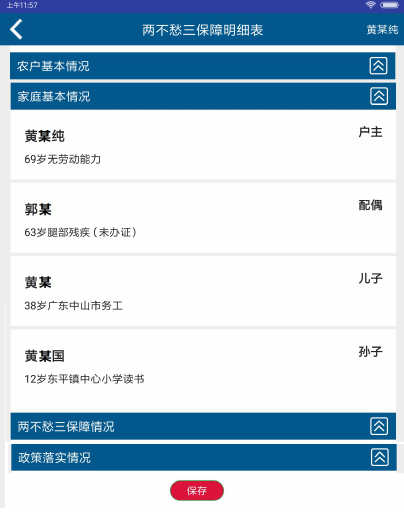
Figure 2. Monitoring APP screenshot